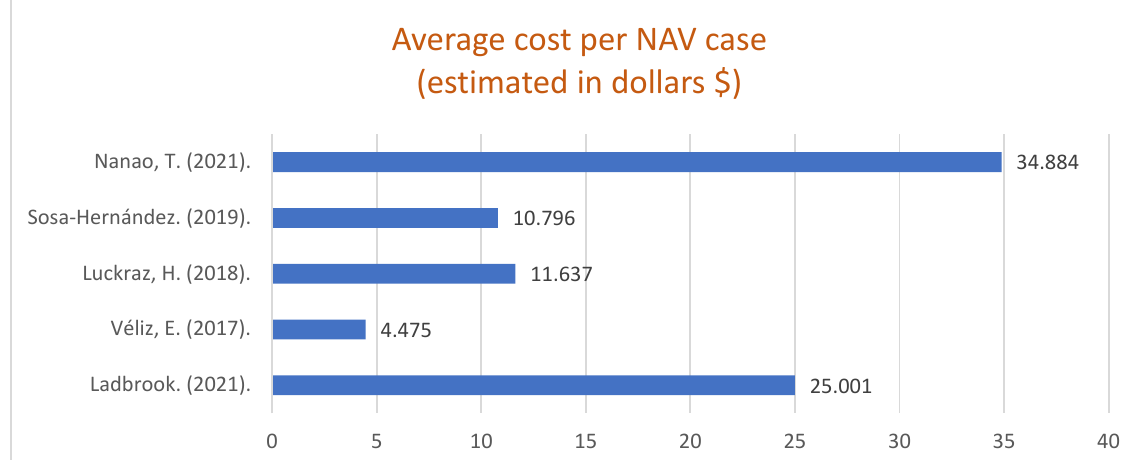
Figure 2. Results average health cost per case of VAP [60–64].